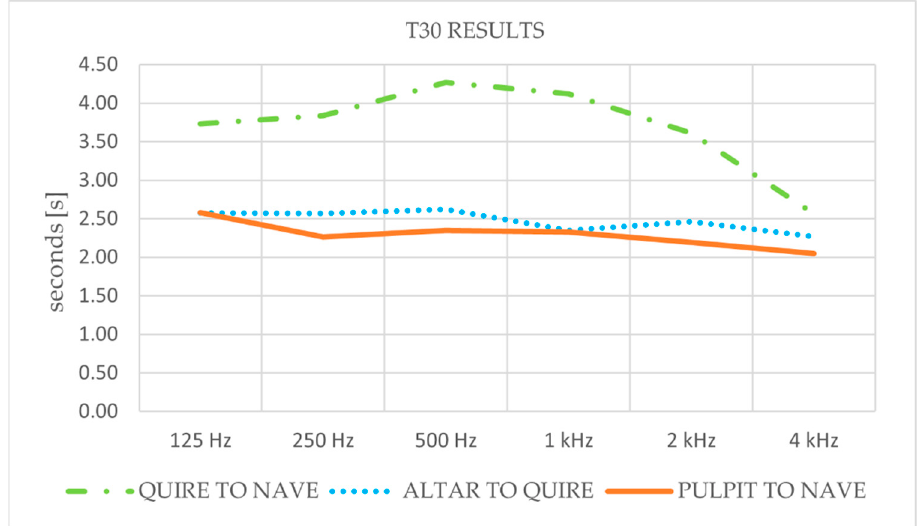
Figure 8. T30 comparisons over standard frequency bands.